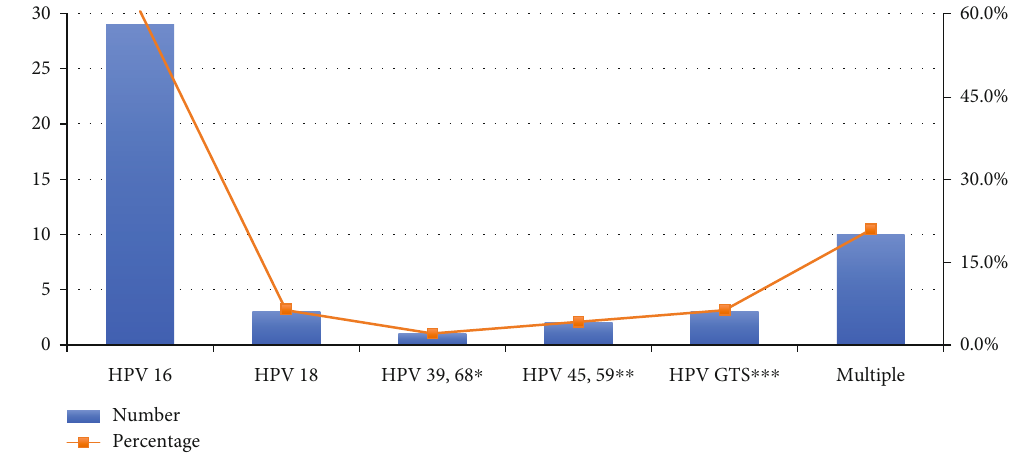
Figure 3: Distribution of HPV genotypes among HPV-positive patients.